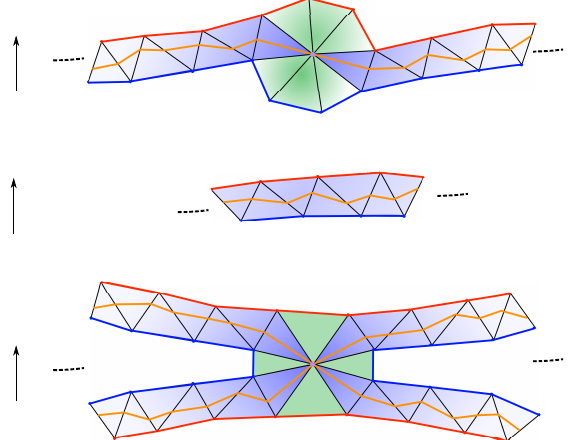
Figure 7. The set of vertices, edges, and faces in the mesh M , which f − 1 ( t ) intersects. The top two figures depict cases where t is a regular value. The top figure shows an example of when there exists a vertex v in M , such that v ∈ f − 1 ( t ) . The second figure shows the case where no such a vertex exists. In other words, f − 1 ( t ) intersects only edges and faces of M . The third figure is an example of the local neighborhood, a critical point of f or when f − 1 ( t ) contains a critical point. The purple simplices represent the set CR f ( t ) . The union of the green and purple simplices represents the set CR f ( t ) . The blue edges and nodes are the edges in the complexes that are shown in the figure and nodes in CR f ( t ) , which have f -values less than or equal to t . The red edges and nodes are the edges in the complexes shown in the figure and nodes in CR f ( t ) , which have f -values that are higher than or equal to t